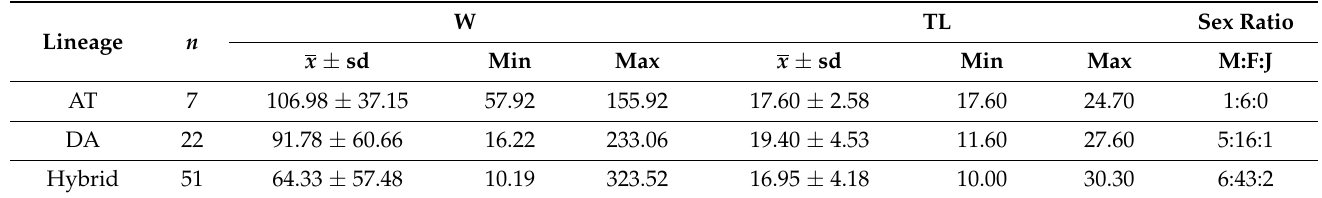
Table 2. Descriptive statistics of sampled brown trout specimens classified by identified lineages ( n = number of specimens; W = weight (g); TL = total length (cm); DA = Danube lineage; AT = Atlantic lineage; M = male; F = female; J = juveniles) (two unclassified specimens